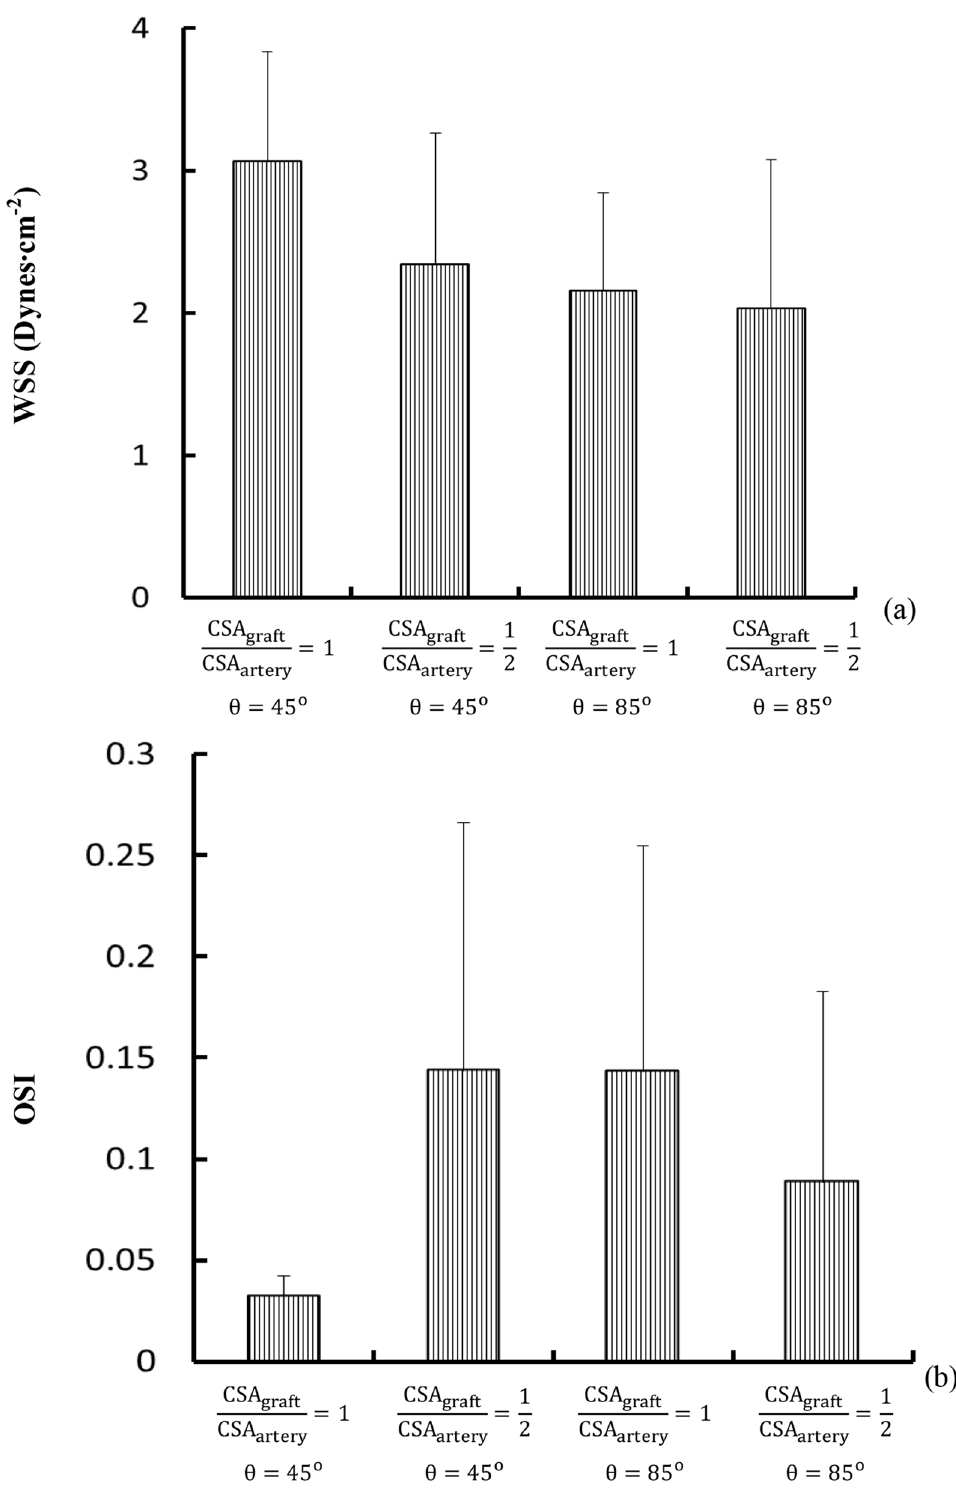
Figure 7. Mean ± SD (a) WSS and (b) OSI in Region A (averaged over all nodes in the region). Region A has surface area of 2.4, 6.8, 7.2, ~ 1 and h =45 u ; CSA graft ~ 1 ~ 1 and h =85 u ; and CSA graft ~ 1 and h =45 u ; CSA graft and h =85 u , respectively. and 7.3 mm 2 for CSA graft 2 2 CSA artery CSA artery CSA artery CSA artery